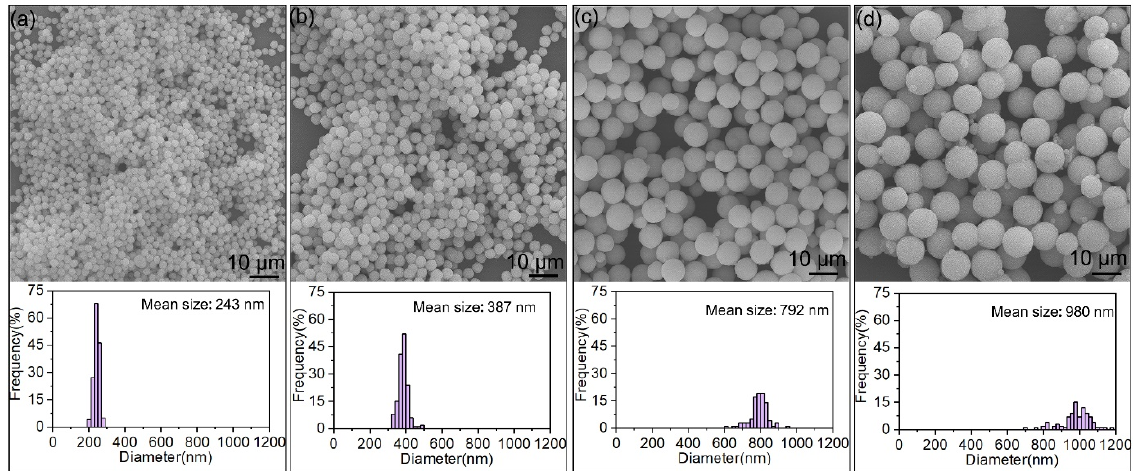
Figure 3. SEM images and size distribution of spherical Y 2 O 3 powders: ( a ) 243 nm; ( b ) 387 nm; ( c ) 792 nm; ( d ) 980 nm.